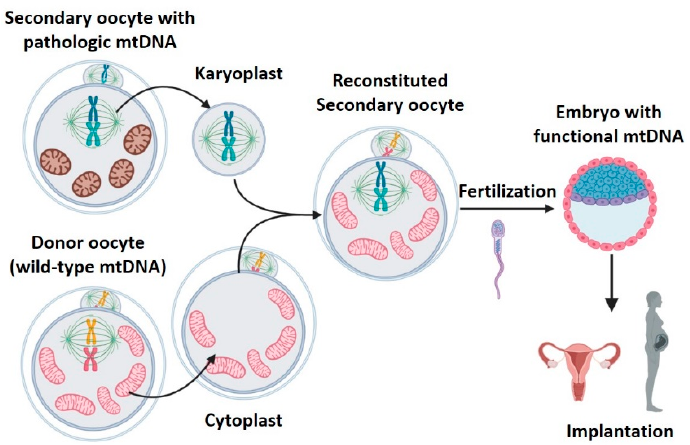
Figure 3. Meiotic spindle transfer (MST). MST consists of transferring the meiotic spindle of a patient’s metaphase II oocyte (with mitochondrial disease) to a healthy enucleated donor oocyte. Created with BioRender.com